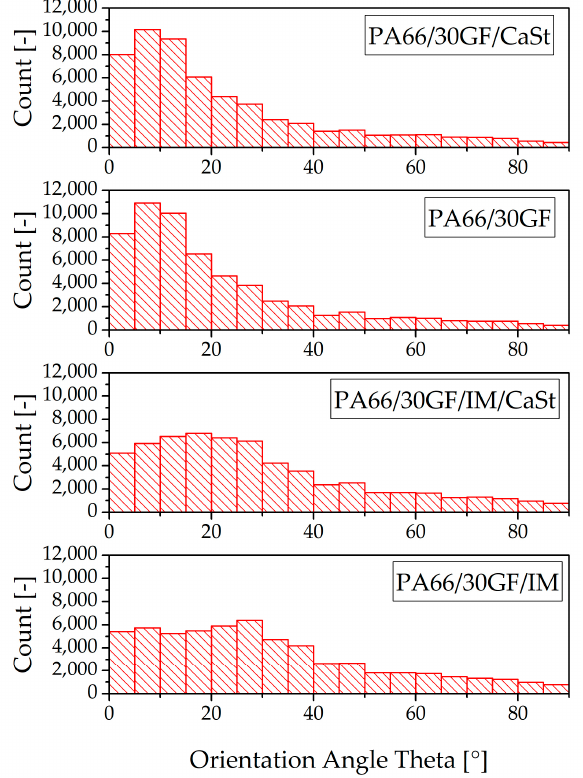
Figure 7. Fiber orientation in tensile specimen shown from 0° to 90°.